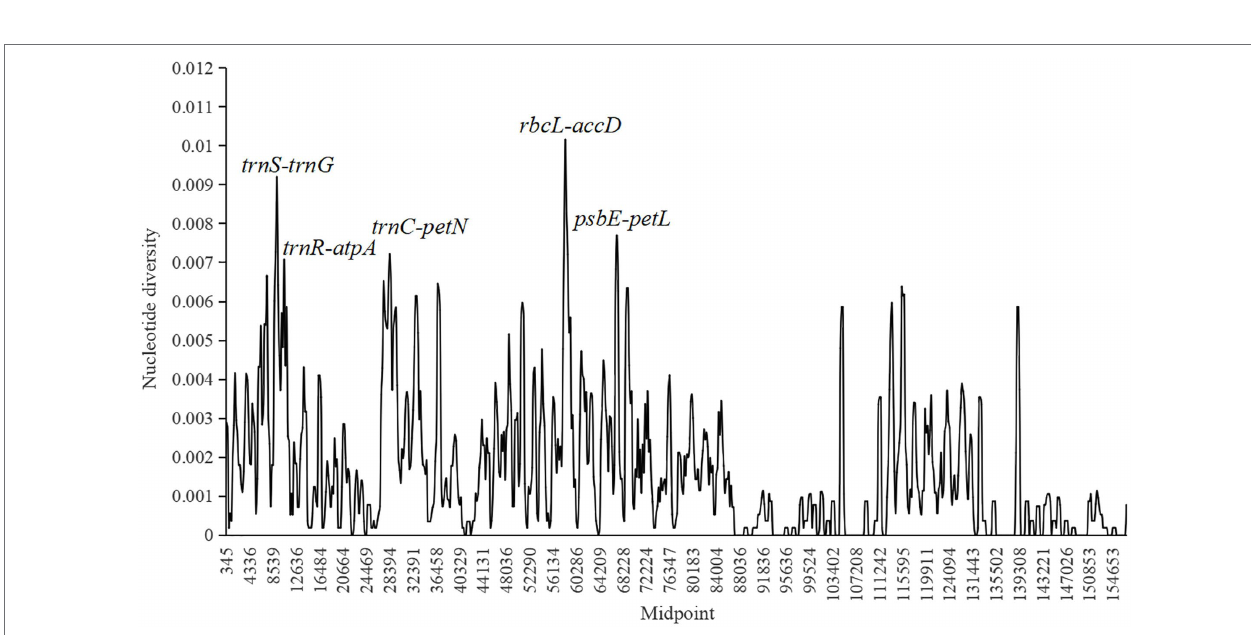
FIGURE 3 | Visualized alignment of the Fragaria chloroplast genome sequences with annotations, using mVISTA. Each horizontal row shows the graph for the pairwise sequence identity with the Fragaria gracilis chloroplast genome sequence. The x -axis represents the base sequence of the alignment, and the y -axis represents the pairwise percent identity ranging from 50 to 100%. Gray arrows indicate the position and direction of each gene. Red indicates non-coding sequences (CNS); blue indicates the exons of protein-coding genes (exons); lime green indicates ribosomal RNA (rRNA) or transfer RNA (tRNA)